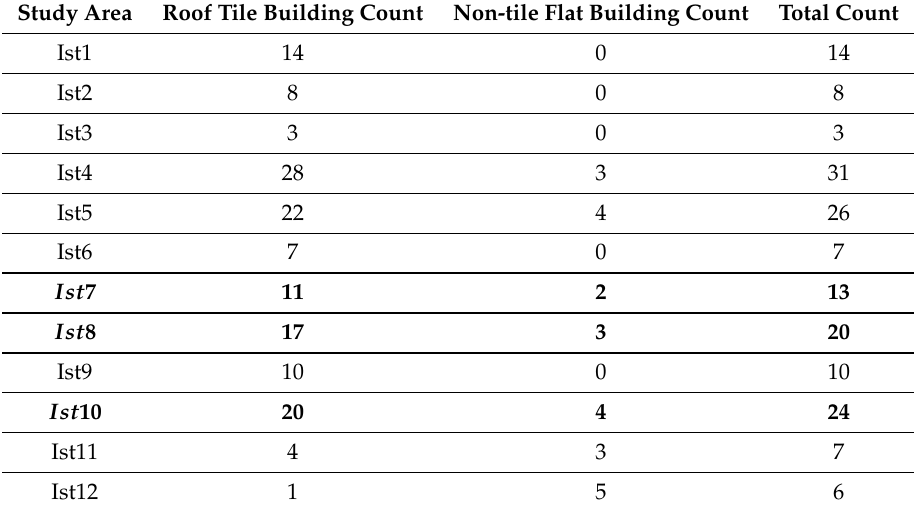
Table 6. Relevant image ground truth details of the Istanbul dataset . Study